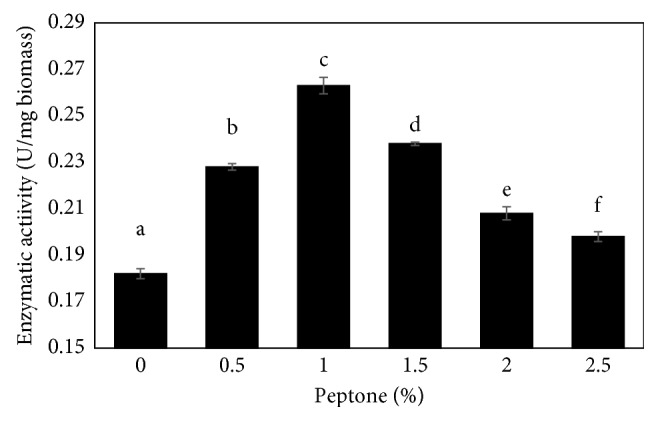
The effect of the concentration of peptone on glucose isomerase production. Peptone is the second nitrogen source for bacterial growth and enzyme synthesis; therefore, the concentration of peptone may affect the glucose isomerase activity. In this study, the concentration of peptone was increased from 0 to 1% along with an elevation of enzyme activity from 0.182 ± 0.002 to 0.263 ± 0.004 U/mg biomass (p < 0.05). Then, the enzyme activity decreased along with the higher increase of peptone concentration (1.5–2.5%). Therefore, we chose 1% peptone as the optimal concentration to produce glucose isomerase.